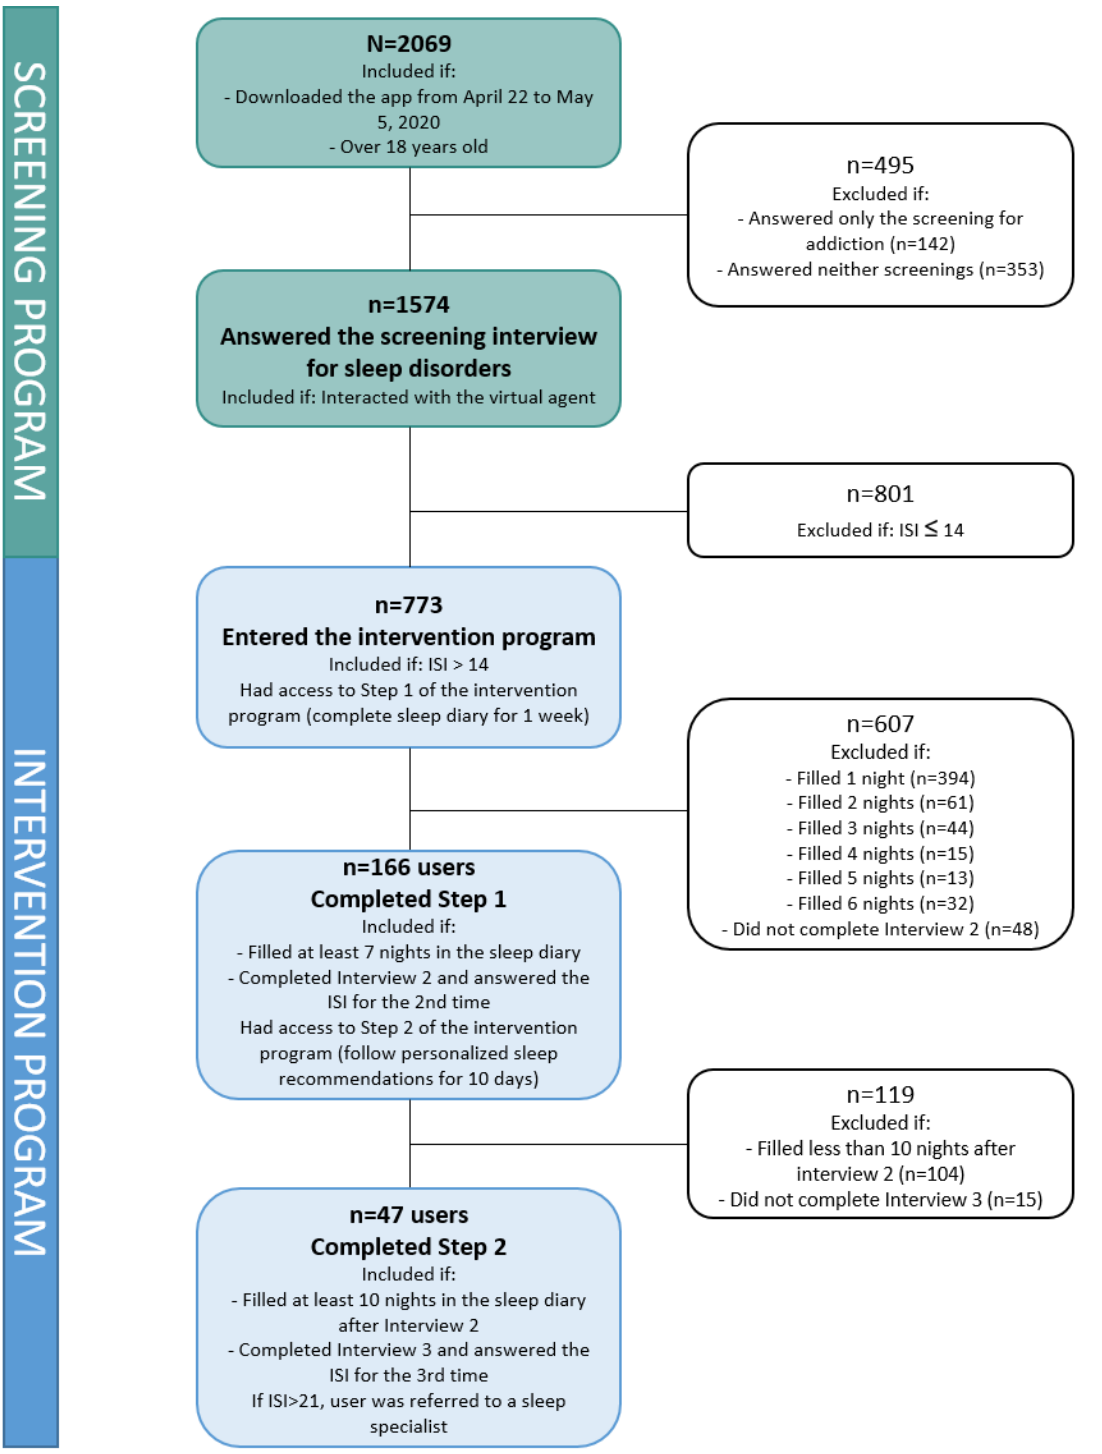
Figure 3. Flowchart of users included in the different steps of